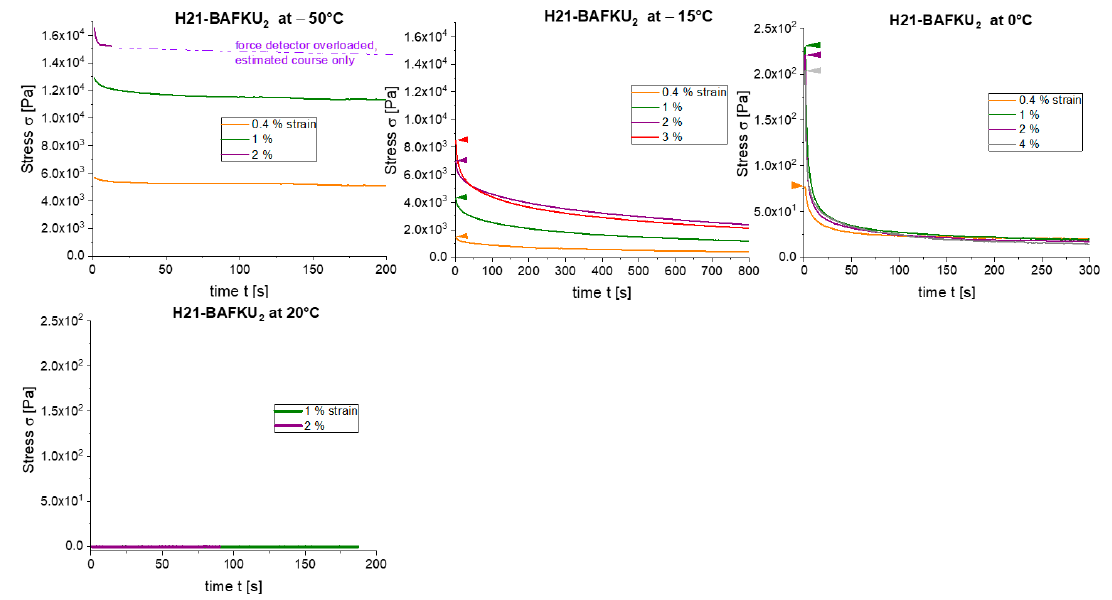
Figure 8. Stress relaxation tests of H21–BAFKU 2 at di ff erent temperatures; at each temperature, several constant strain values were Figure 8.